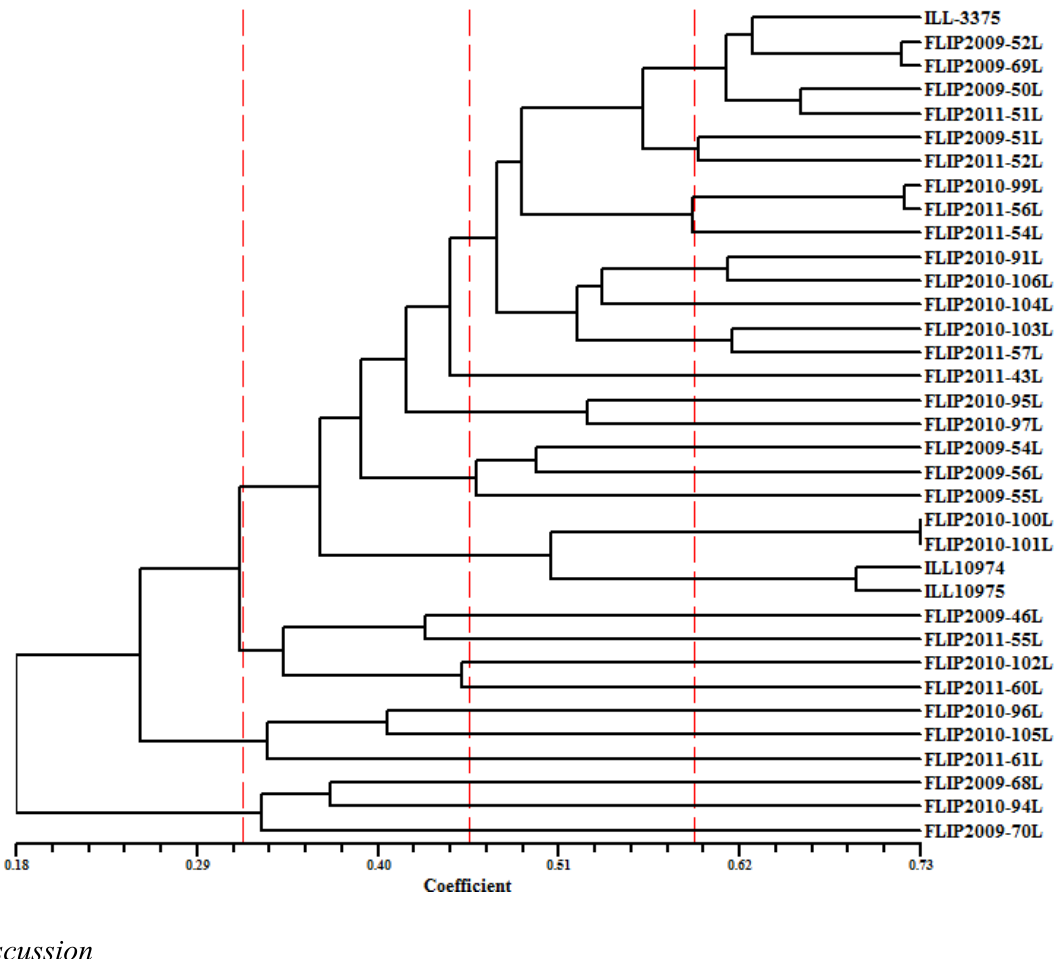
Figure 3. Dendrogram of 35 lentil genotypes generated from Amplified fragments length polymorphism AFLP markers by Jacc,ard’s coefficient and UPGMA (unweighted pair group method with arithmetic average) clustering method. Similarity values are shown at bottom of